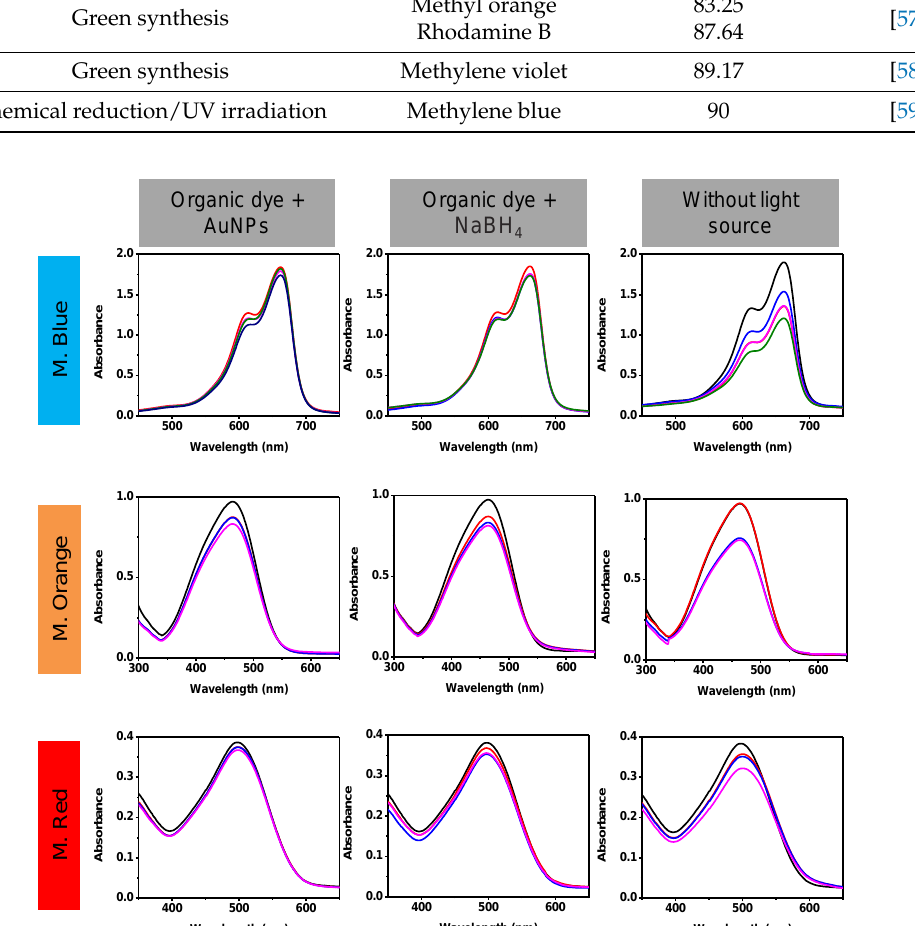
Figure 9. UV-Vis analysis of the blind tests for methylene blue, methyl orange, and methyl red degradation.